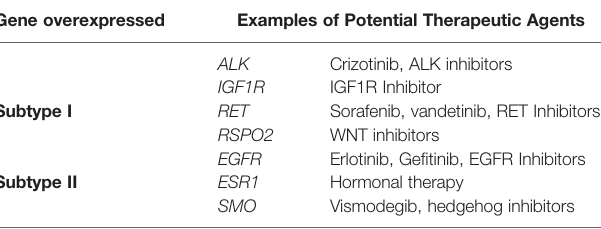
TABLE 1 | Target genes enriched in each molecular